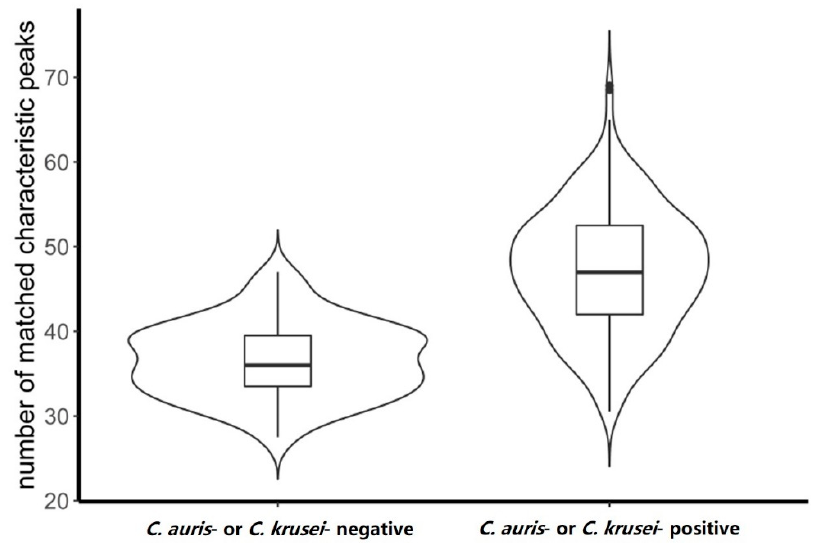
Figure 1. Violin plot of the number of matched characteristic peaks C. auris - or C. krusei -positive and -negative samples. Wider sections in the violin plots represent a higher probability; the skinnier sections represents a lower probability. The boxplot inside shows that the lower end of the box represents the first quartile while the upper end was the third quartile; the median value is marked with the bold black line in the center of the